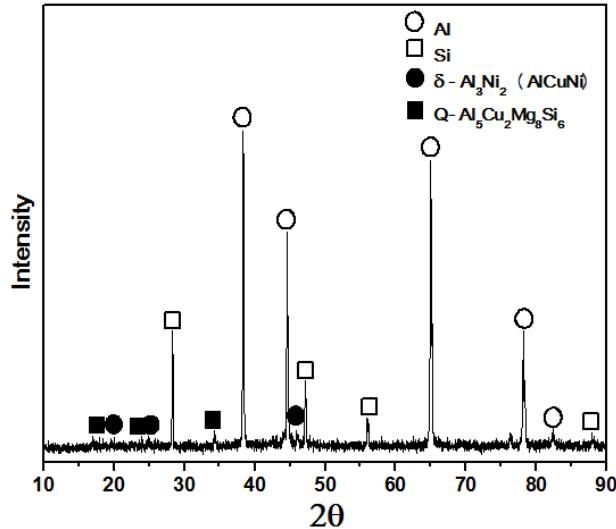
Figure 4. XRD result of the as ‐ received alloy.